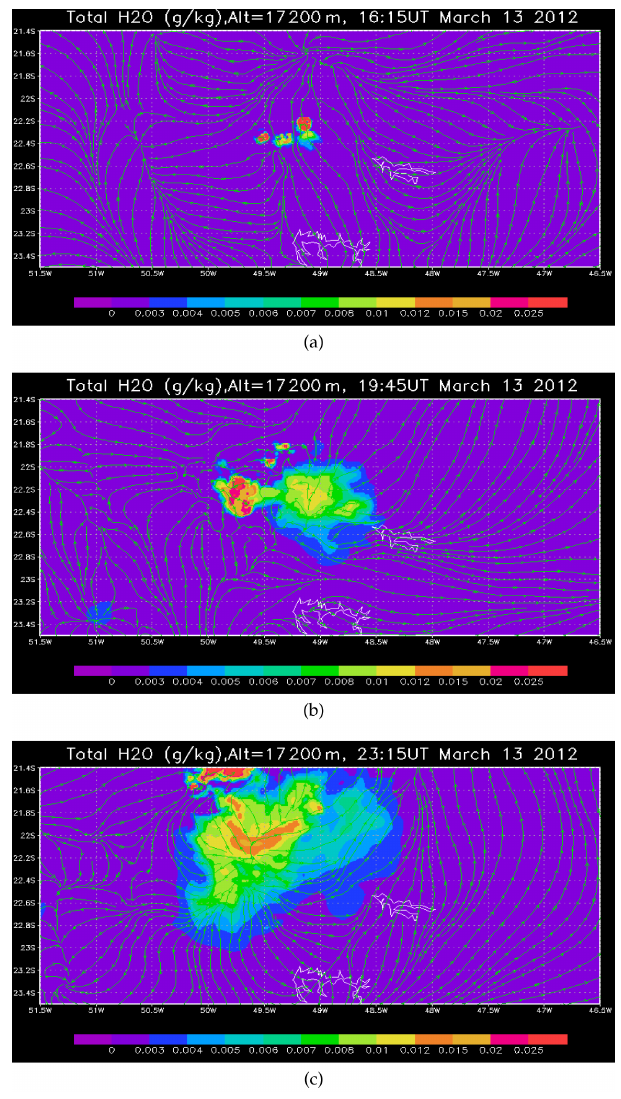
Figure 2. BRAMS simulation: REF total water content, ice, liq- uid, and vapour in gkg − 1 , at 17.2km altitude at (a) 16:15UT, (b) 19:45UT, and (c) 23:15UT, respectively. The streamlines rep- resent the horizontal wind fields within the domain, a composite of the second and third